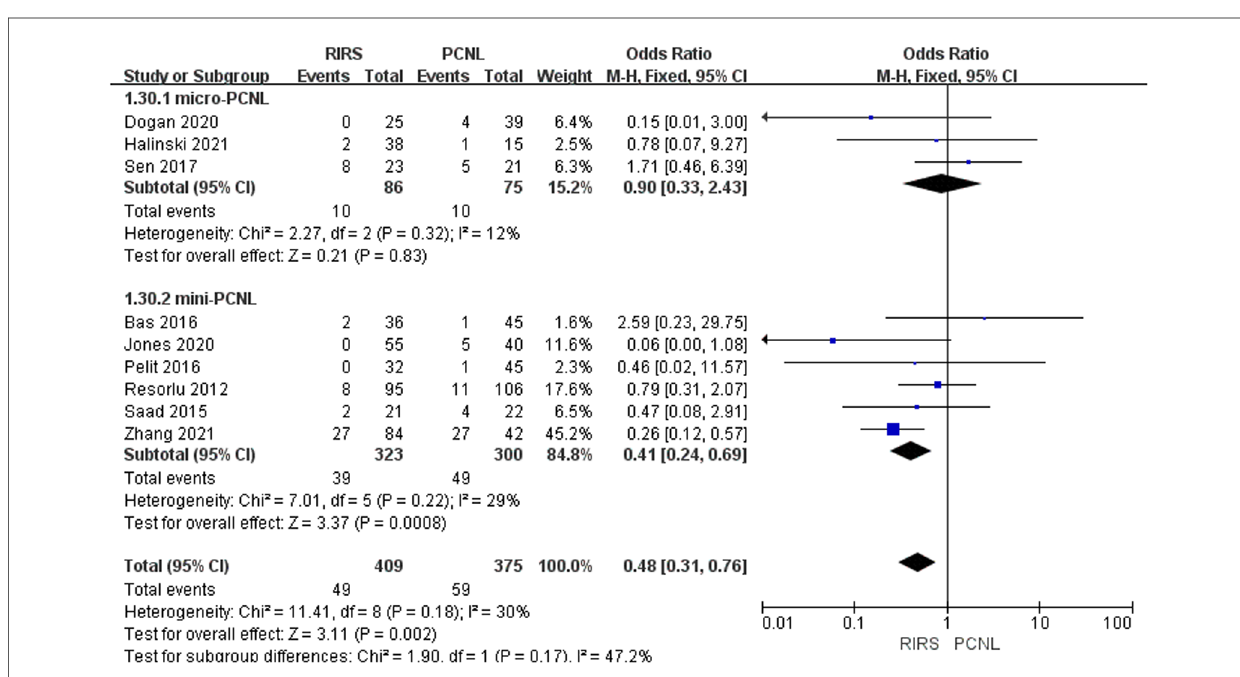
FIGURE 9 Forest plot of Clavien – Dindo grade I complication rate analysis between RIRS group and PCNL